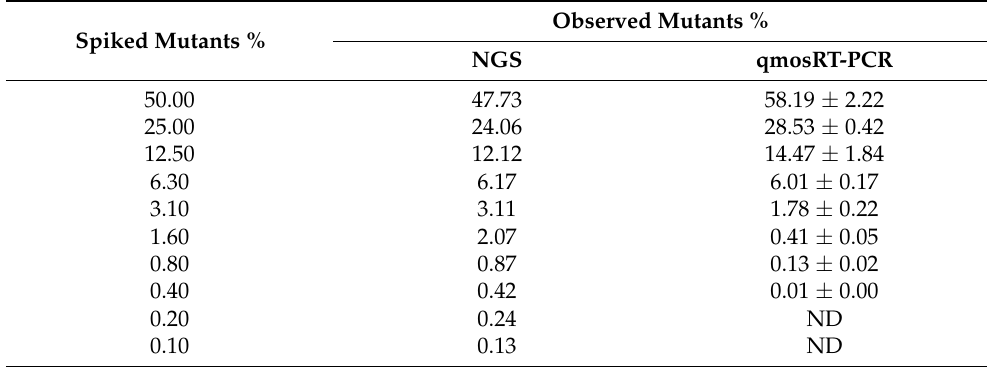
Table 2. Quantification of nOPV2-c1_171 mutants in plasmid-spiked samples by qmosRT-PCR assay using plasmids as reference standards.